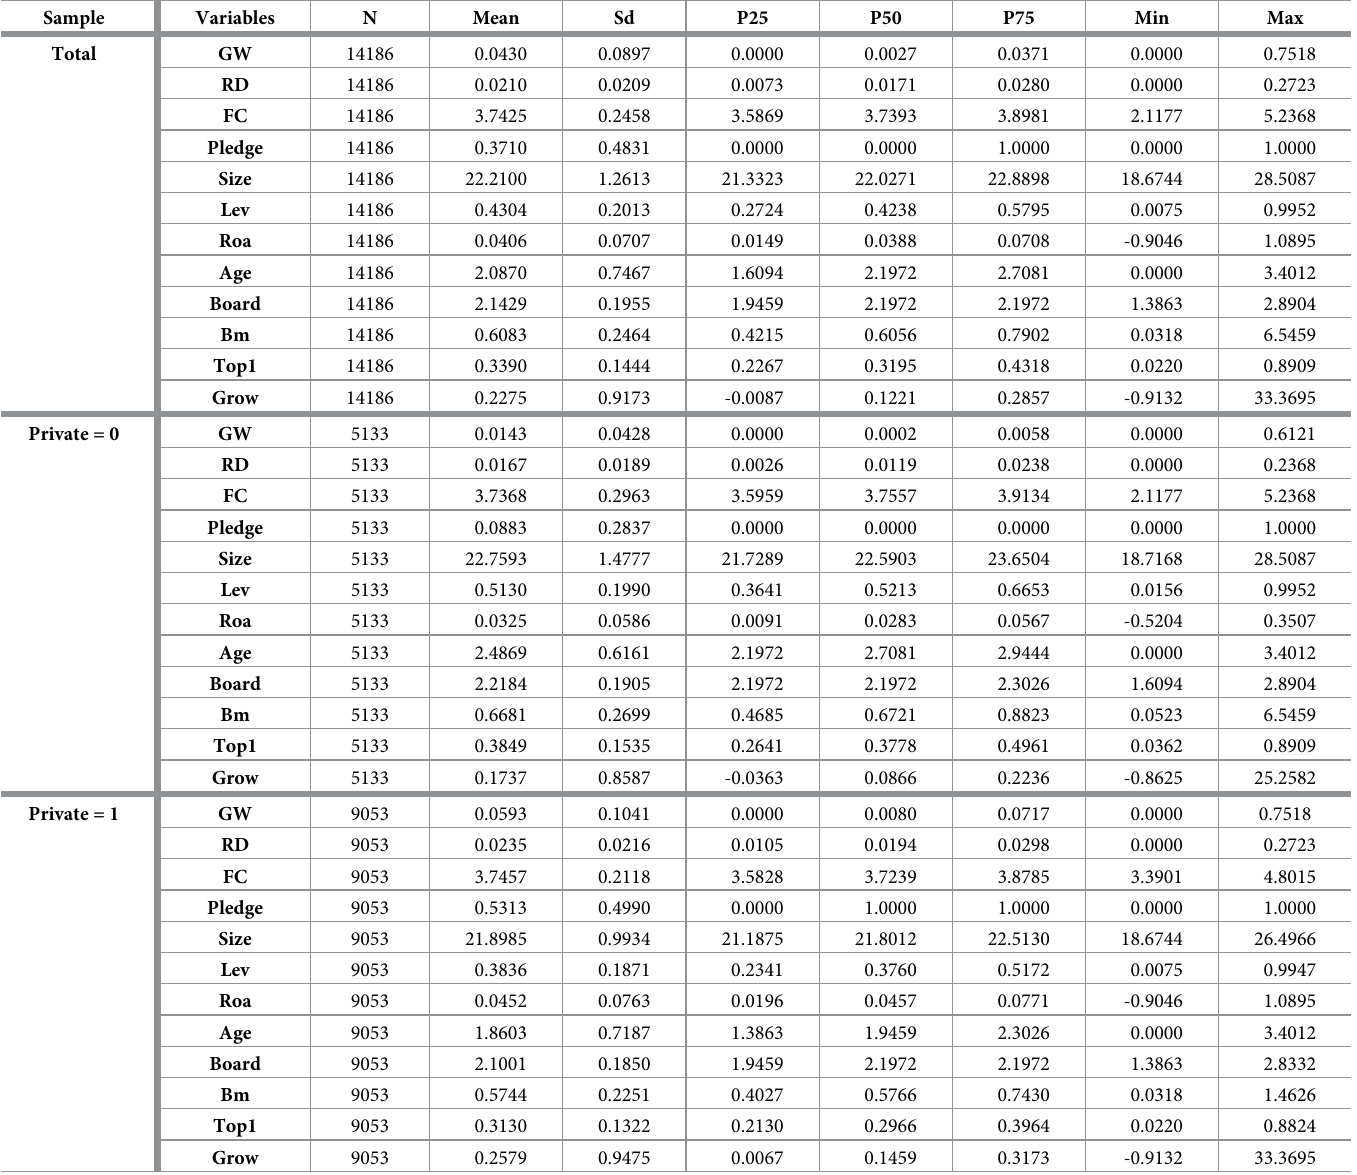
Table 2. Summary